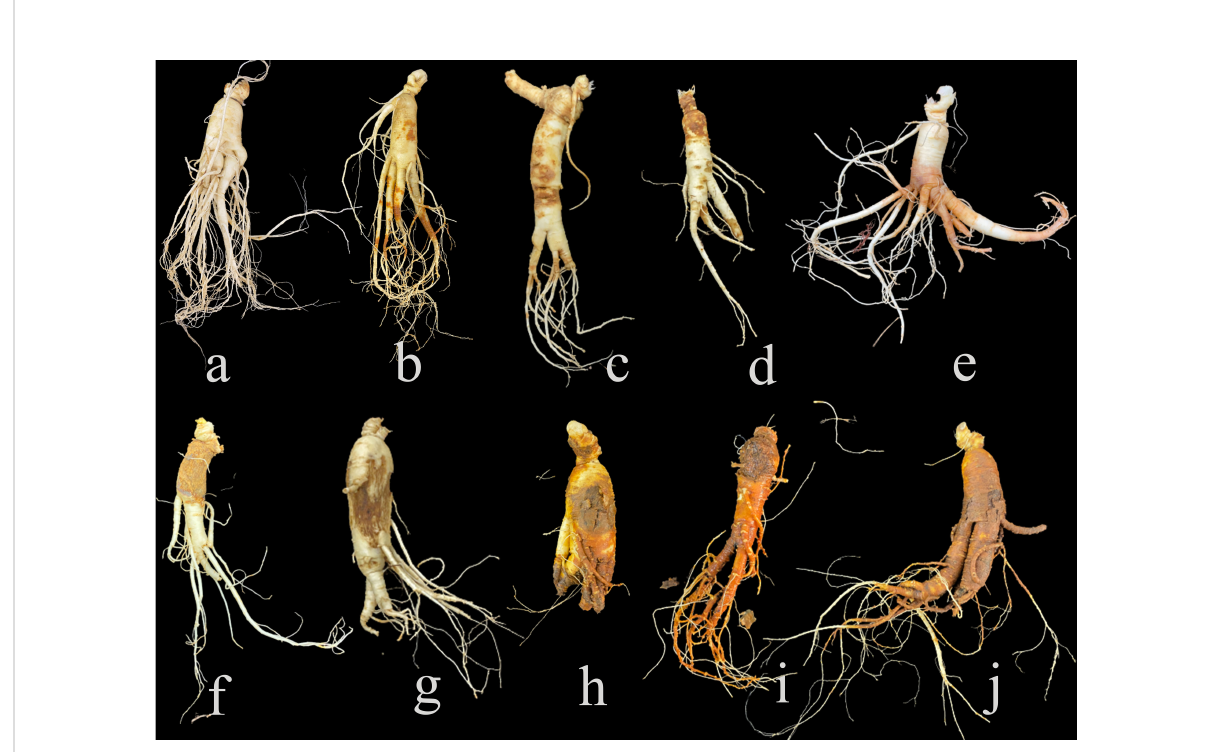
FIGURE 1 Symptoms of diseased ginseng roots collected in the fi eld. (A) is healthy root, (B – J) are various diseased